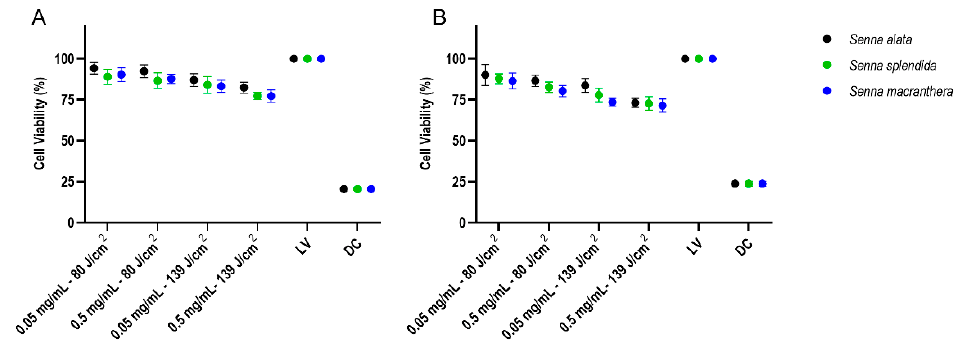
Figure 5. Percentage of cell viability of the oral keratinocyte culture after treatment with plant materials not exposed ( A ) and exposed ( B ) to light. Two-way ANOVA with graphics with mean ± confidence interval.